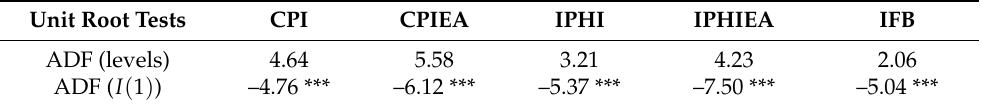
Table A2. The unit root tests—the integration 𝐼(𝑑) (base period January 2000), data vector 2000 to 2012.